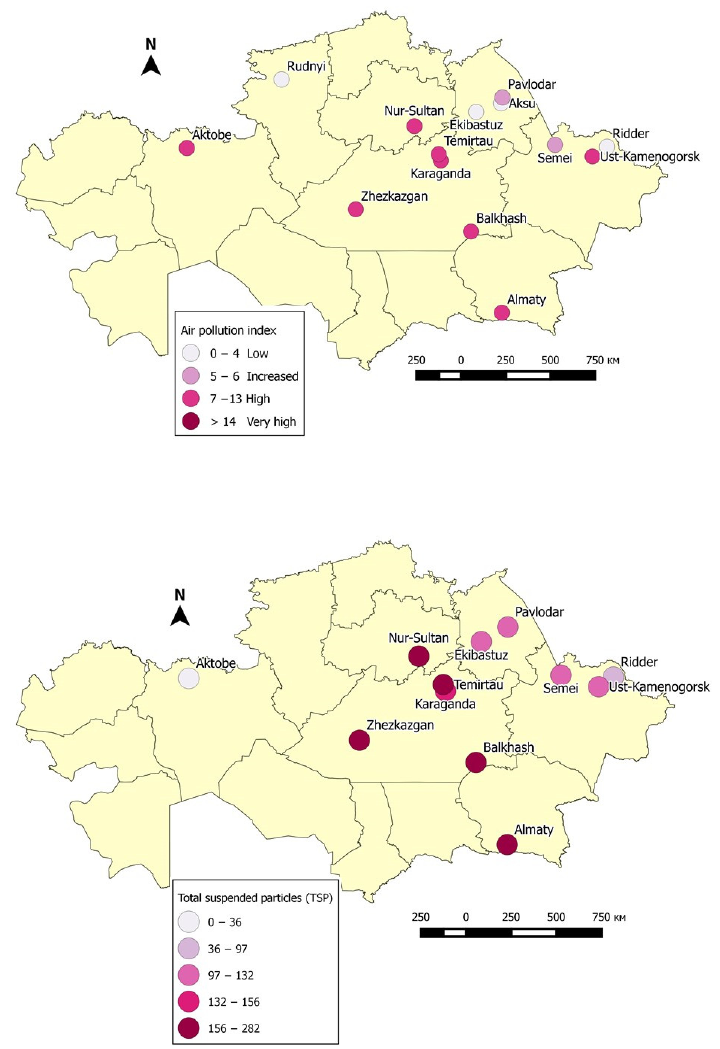
Figure 1. Air pollution index in 2019 ( upper map ) and average annual concentrations of TSP in the cities of Kazakhstan in 2019, µg m − 3 ( bottom map ). Data source: [33].